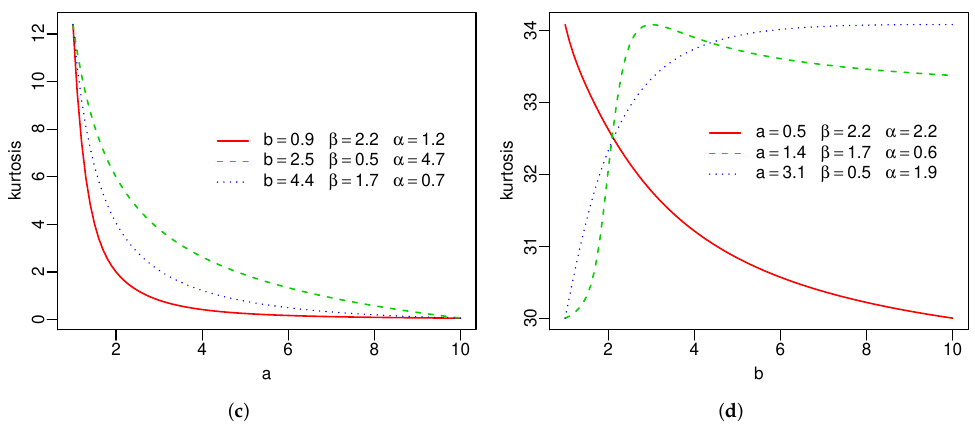
Figure 3. Skewness and kurtosis of the SW ( a , b , β , α ) distribution( a – d